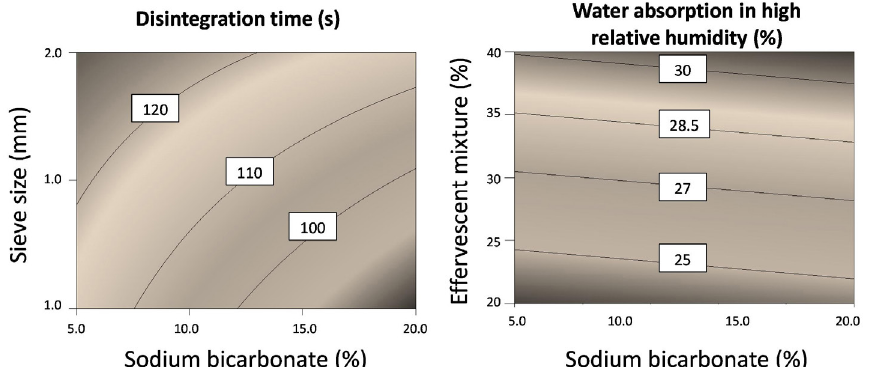
FIGURE 4 - Contour diagrams of Maytenus ilicifolia effervescent granules developed according to factorial design for disintegration time and water absorption in high relative humidity. Each contour represents a constant response